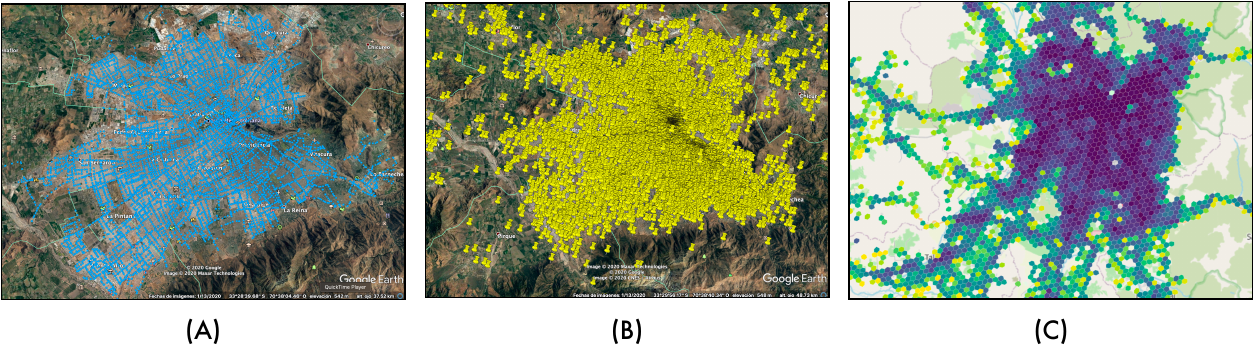
Figure 1. Capturing mobility patterns of MR through three sensing methodologies. Panel ( A ) shows around 12,000 bus stations in the MR public transport network. The O-D matrices are estimated by the flow of passengers between these bus stations. Panel ( B ) indicates the network of cell phone antennas that provide coverage in the MR. The mobility index is determined by the flow of mobile phone users and the records they leave on the antennas covering the service while they are moving. Panel ( C ) shows level-6 hexagons covering the MR on a given day. The highest scores/percentile are in blue, while the lowest is yellow, passing through a range of